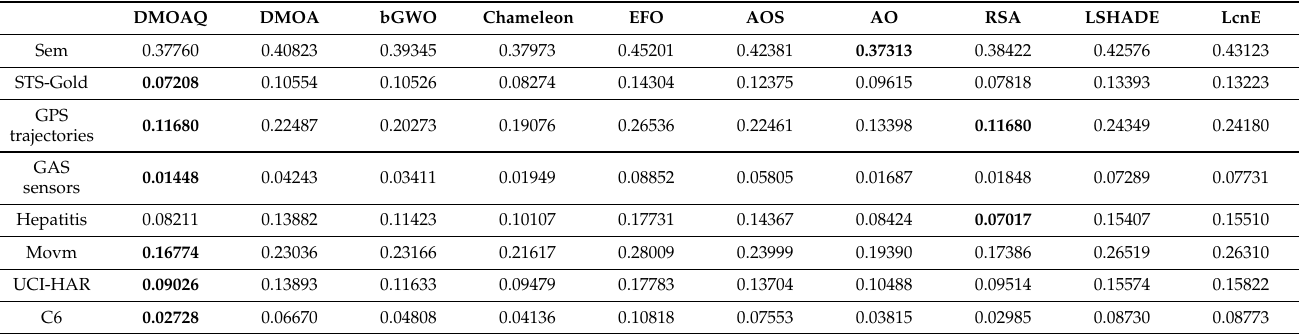
Table 9. Average of the fitness function